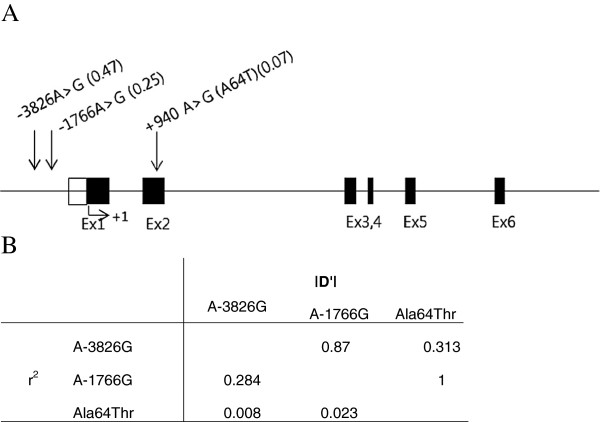
Polymorphisms in UCP-1.A) A map of the SNPs located in the 4q28-q31 locus of the UCP-1 gene. Minor allele frequencies are shown in parentheses. The translation start site is indicated by +1. Open and closed boxes represent the untranslated and translated regions, respectively. B) Linkage distribution among the three SNPs.